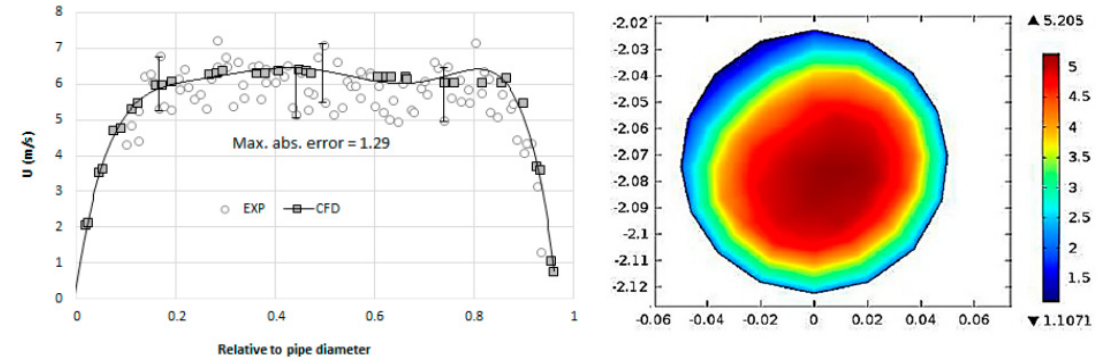
Figure 3. Flow velocity distribution and implications on the system balance efficiency.